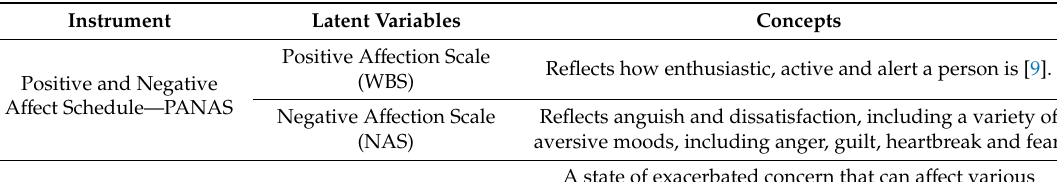
Table 3. Dimensions of the PANAS-GAD-7-IDATE